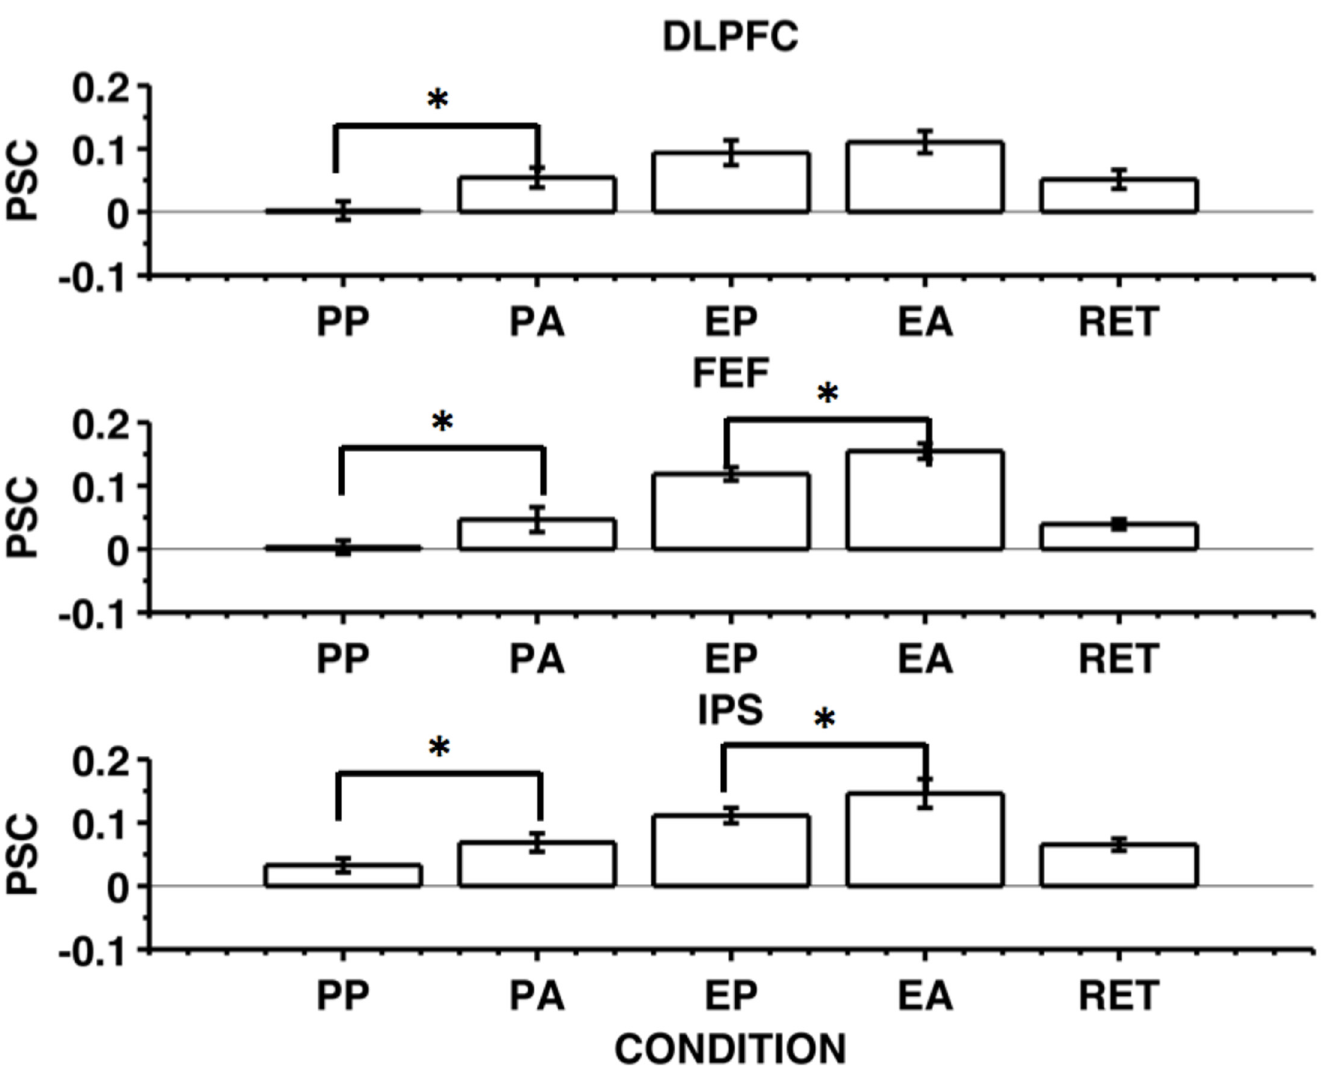
Fig 4. BOLD responses averaged across 12 hemispheres from 6 subjects for preparation and execution of pro-saccades and anti-saccades, shown for the DLPFC (upper row), FEF (middle row) and IPS (bottom row). Starting from the left, the first two bars shows the activity time-locked to the onset of the cue to prepare a pro-saccade (PP) and an antisaccade (PA). The third and fourth bars show the activity time-locked to the cue to execute a pro-saccade (EP) and an anti-saccade (EA). The last bar on the right shows the activity time-locked to the cue to perform a return saccade from the peripheral landmark to the central fixation cross